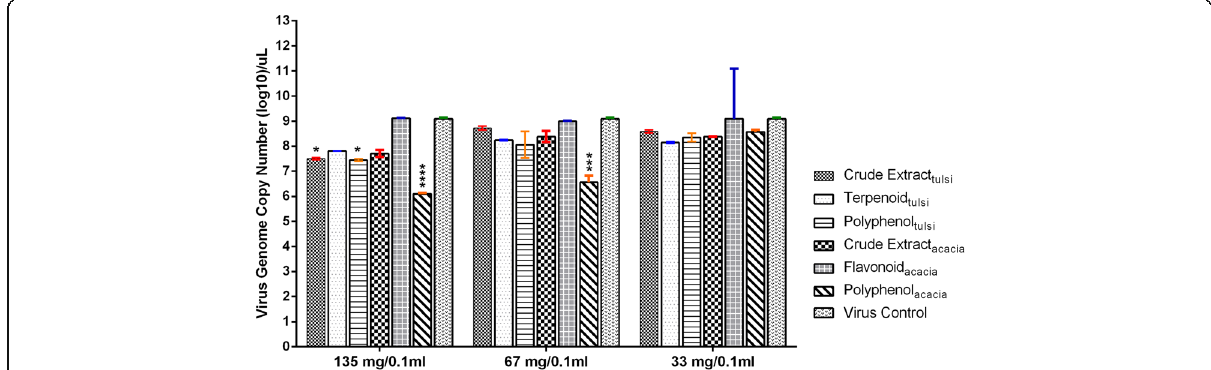
Fig. 5 Assessment of prophylactic activity of the O. sanctum and A. arabica leaves extracts in a dose-dependent manner by Real Time RT-qPCR assay. Each error bar represents standard deviation (SD) from the 5 ECEs. The virus control group included 500 EID 50 /0.1 ml of H9N2 virus. Statistical significance was assessed by two ways analysis of variance (ANOVA) with Tukey post-hoc test (* p <0.05, ** p <0.01, *** p <0.001, **** p